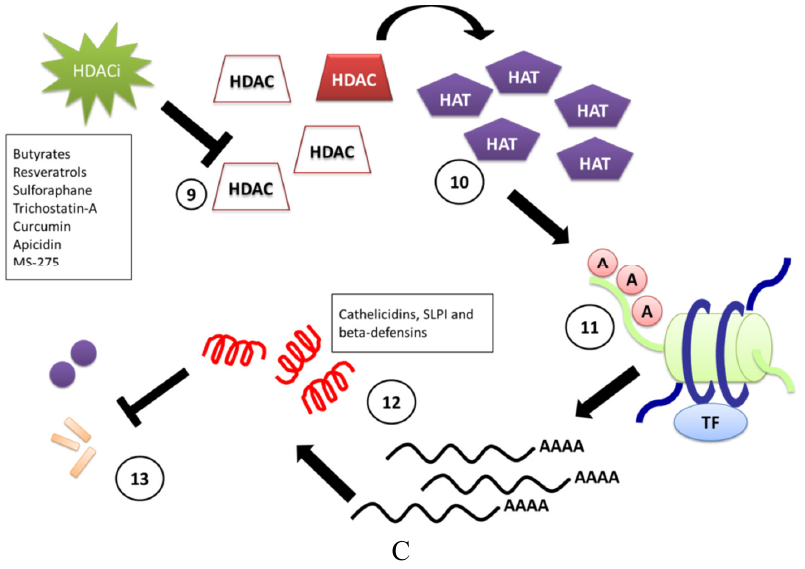
Figure 1. Pictorial description of chromatin remodeling resulting from the interplay between chromatin modifying enzymes and pathogens. ( A ) There is scientific evidence to assume that the enzyme histone acetylase adds acetyl groups to specific amino acids on the free N-terminal of histone proteins (not embedded in the octamer) (1), as a result of which the chromatin coiled around the histone octamers undergoes changes in spatial configuration exposing parts of DNA to which transcription factors bind (2). This change in DNA topography allows for a particular region of DNA to be transcribed and translated (3,4), thus regulating some important cellular functions including immune responses to pathogen invasion; ( B ) Several pathogens have evolved mechanisms to induce HDAC expression, which causes removal of acetyl groups attached to N-terminal histones, affecting the transcription and translation of many genes, including those involved in pathogen recognition, immunity and CAMP production (6–8). Examples include Shigella dysenteriae , Vibrio cholerae and Anaplasma phagocytophilum and Porphyromonas gingivalis . The mechanism(s) by which bacteria induce HDAC expression has not been well studied, although bacterial toxins or other cellular components ( i.e ., lipopolysaccharide, LPS) have been shown to play a role in some cases (5); ( C ) Chromatin remodeling can be regulated by HDACi, which directly interact with the HDAC enzyme and cause a state of hyperacetylation (9,10). This hyperacetylation can lead to a global change in gene expression. HDACi-induced over-expression of CAMP-encoding genes (11,12) has led to the idea of developing the HDACi as novel therapeutics for controlling bacterial infections in conjunction with antibiotic treatment